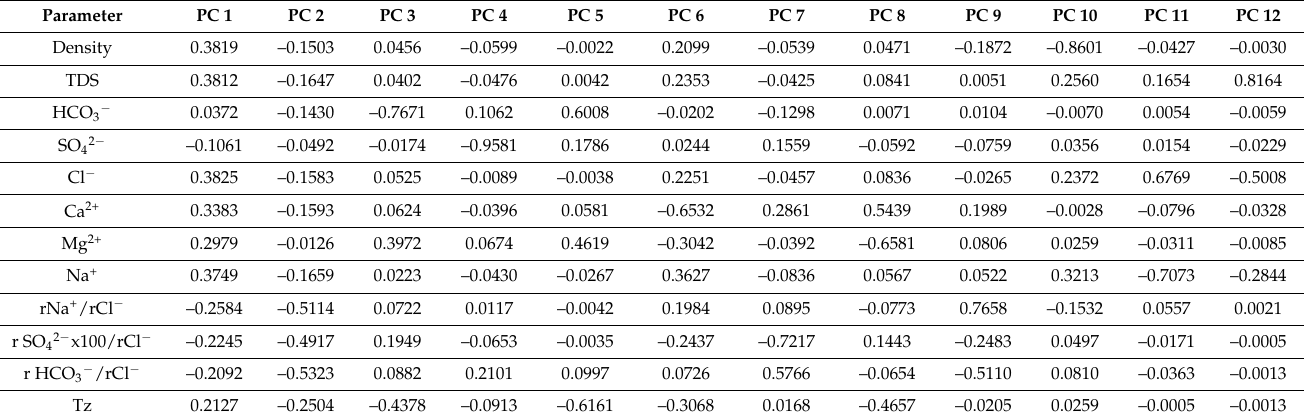
Table 6. Factor loadings for individual principal components (PC; from 1 to